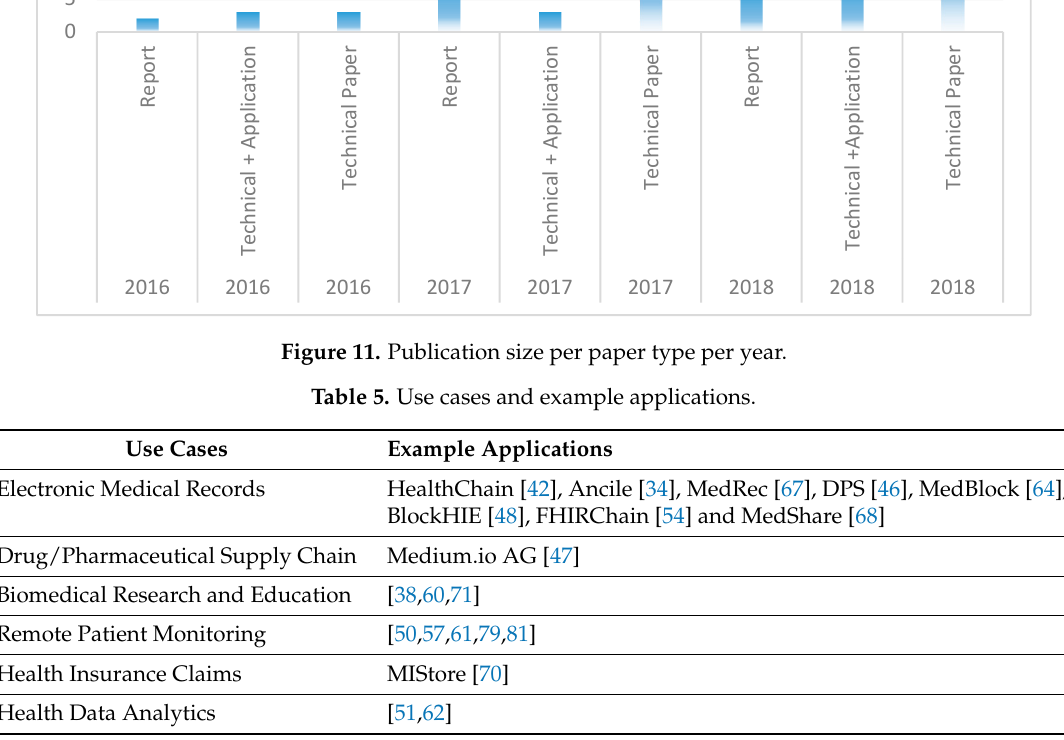
Figure 10. Selected paper types.